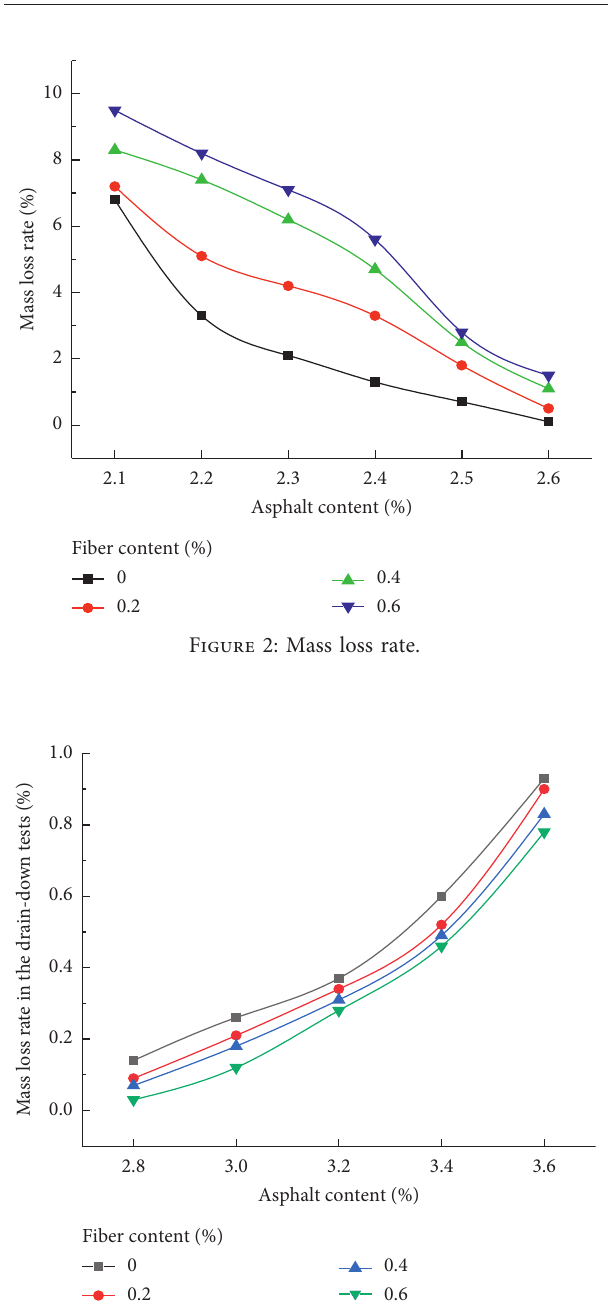
Figure 3: Mass loss rate in the drain-down